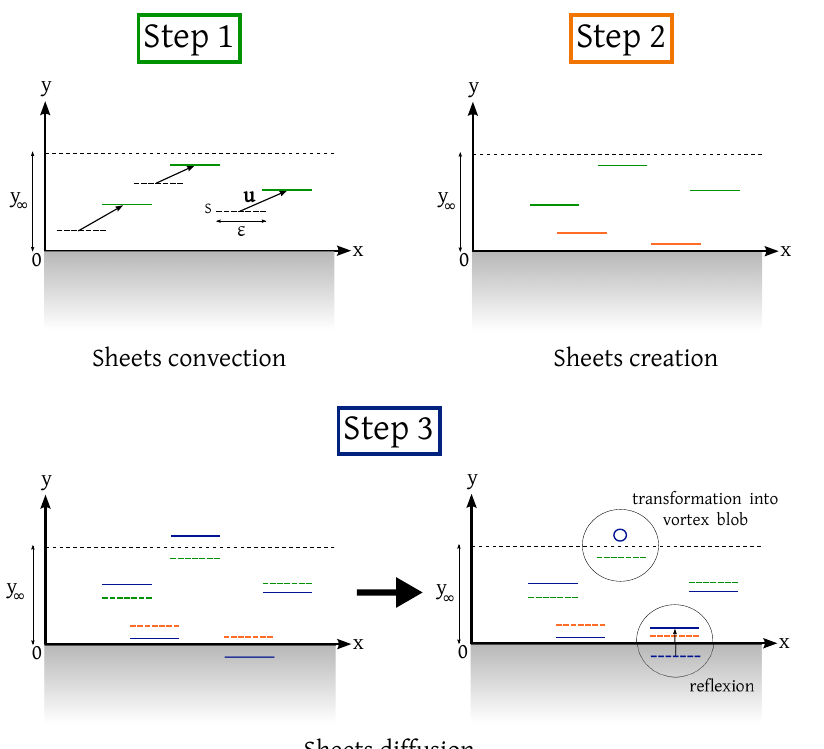
Figure 7. Steps of the vortex sheet/vortex blob